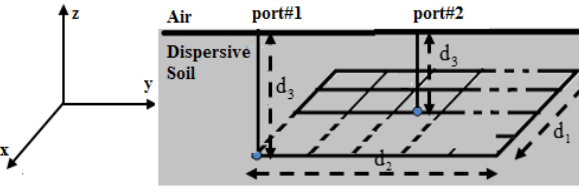
Figure 4: Scematic diagram of two-port grounding grid of arbitrarily-numbered meshes buried in lossy dispersive